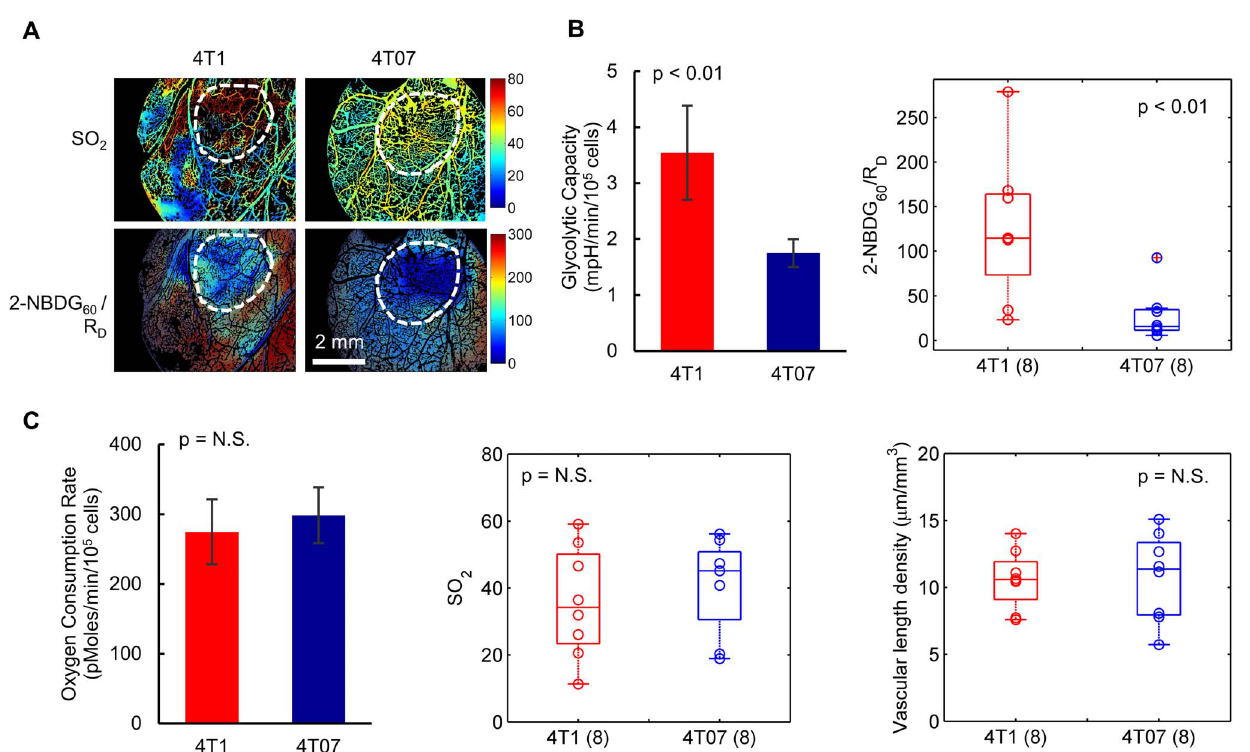
Fig. 5. Delivery-corrected glucose uptake reveals distinct glycolytic phenotypes in metastatic (4T1) and non-metastatic (4T07) mammary tumors. (A) Representative images of vascular oxygen saturation (SO 2 ) and delivery-corrected 2-NBDG (2-NBDG 60 /R D ) for a 4T1 tumor and a 4T07 tumor, in vivo . (B) 2-NBDG 60 /R D showed contrast in glucose uptake between metastatic 4T1 and non-metastatic 4T07 tumors in vivo (p , 0.01). A Seahorse Glycolysis Stress Test also revealed that the glycolytic capacity, defined as extracellular acidification rate (ECAR) after blockade of respiration by oligomycin, was significantly greater for 4T1 than for 4T07 (p , 0.01). (C) Mean vascular oxygen saturation (SO 2 ) was comparable for 4T07 and 4T1 tumors in window chambers (p 5 N.S.). Vascular density was indistinguishable between tumor lines (p 5 N.S.). A Seahorse Glycolysis Stress Test showed that oxygen consumption rate (OCR) is comparable for 4T1 and 4T07 tumors (p 5 N.S.). Number of mice per group indicated by group name on axis. For Seahorse results, n 5 12 cell samples from 3 distinct assays. Midline of box plots show median, box edges correspond to 25 th and 75 th percentiles, and scatter points show all data